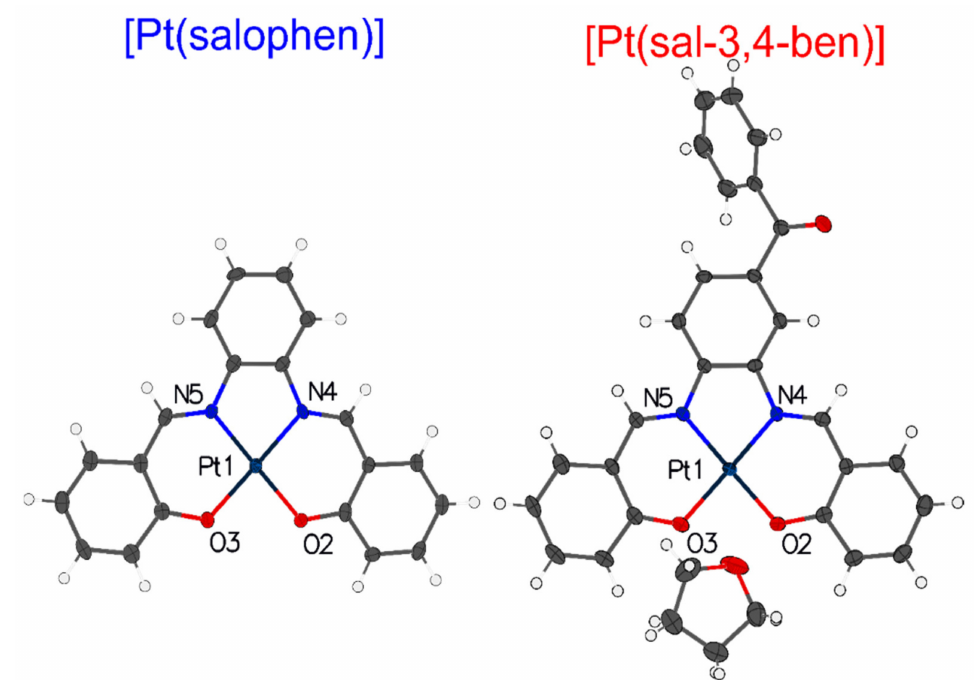
Figure 2. Molecular crystal structures of the [Pt(salophen)] and [Pt(sal-3,4-ben)] coordination compound ellipsoids, with 50% probability, where: hydrogen is the white balls; carbon is the gray ellipsoids; nitrogen is the blue ellipsoids; oxygen is the red ellipsoids; and platinum is the dark-blue